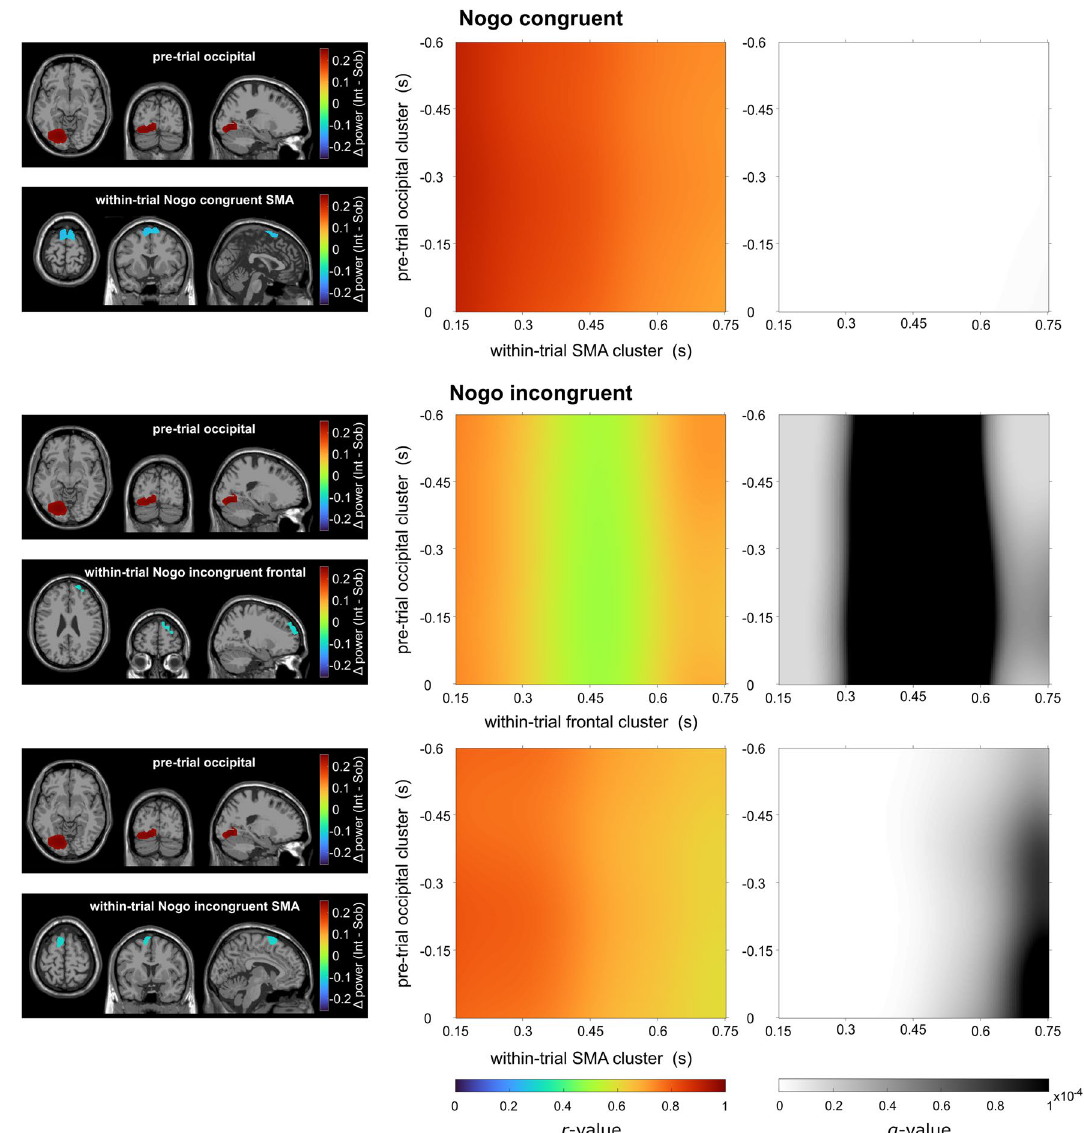
Figure 4. Illustration of the intoxication effect in Nogo trials on the neuroanatomical source level. The left column depicts the brain areas underlying significant changes in theta band activity in the pretrial time window (occipital; intoxicated > sober) and within-trial time window (frontal for incongruent Nogo only, and SMA for both Nogo conditions, intoxicated < sober). The middle column depicts the correlation coefficient for the correlation between the theta band intoxication effects in the pre-trial (y-axis) and within-trial (x-axis) clusters depicted on the left. The right column depicts the associated significance value q (the FDR-corrected p value of each correlation), with brighter colors indicating a higher